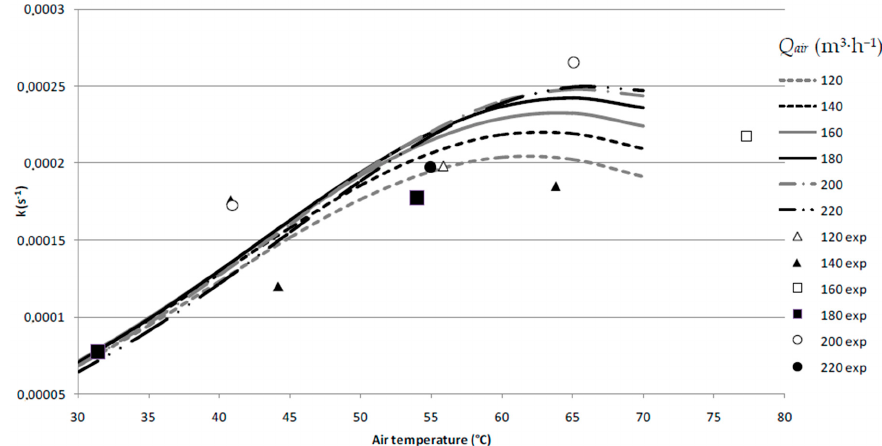
Figure 8. Estimated kinetic parameter ( k ) versus air temperature and flow rate (DOE equation (line) and estimated values (points)).